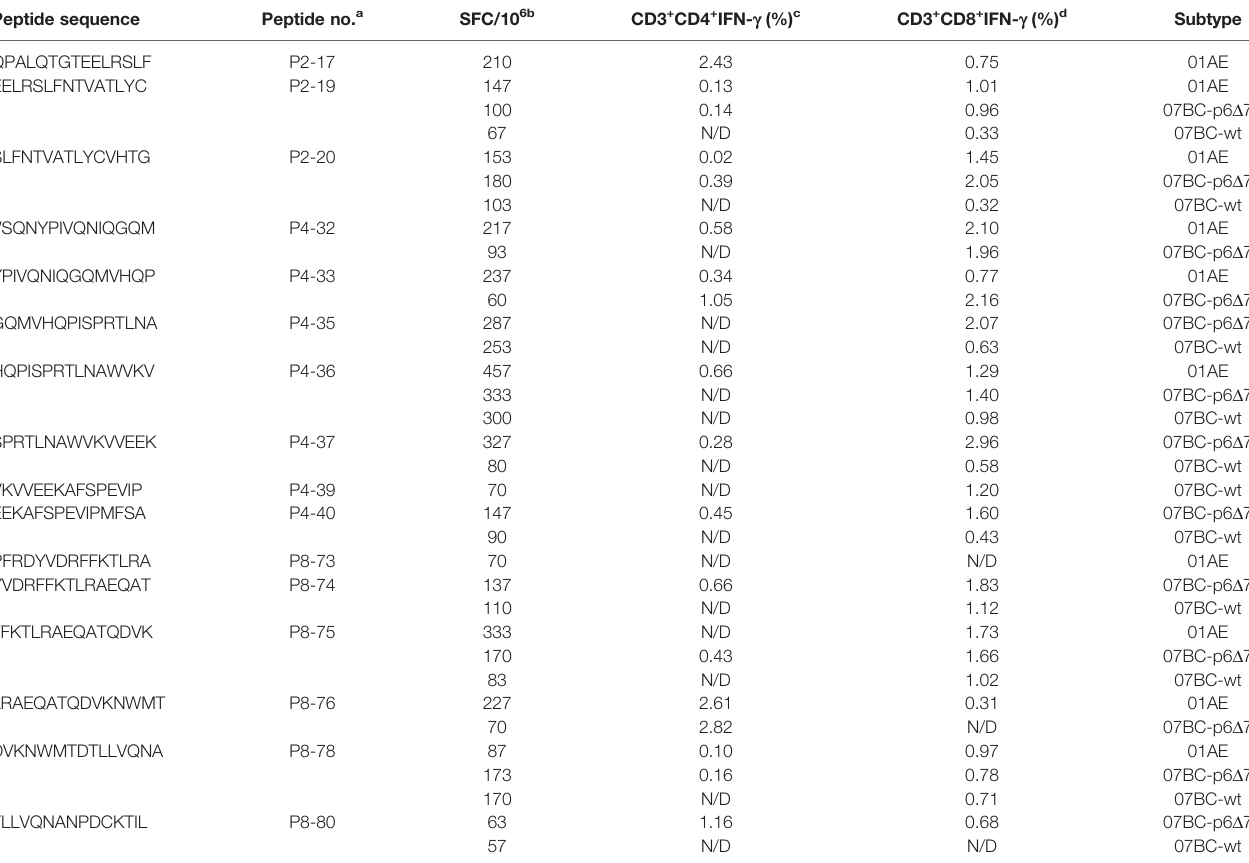
TABLE 1 | Identi fi cation of the T-cell epitope. Peptide sequence Peptide no. a SFC/10 6b CD3 + CD8 + IFN- g (%) d Subtype